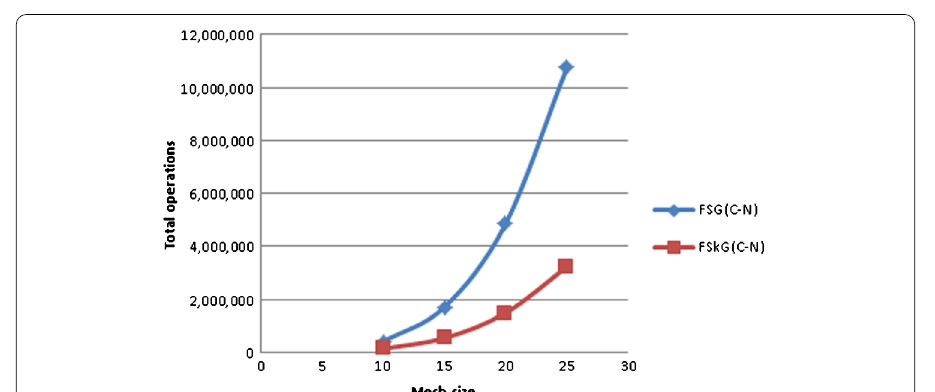
Figure 6 Graph of the total number of operations when α = 0.65 of Example 1